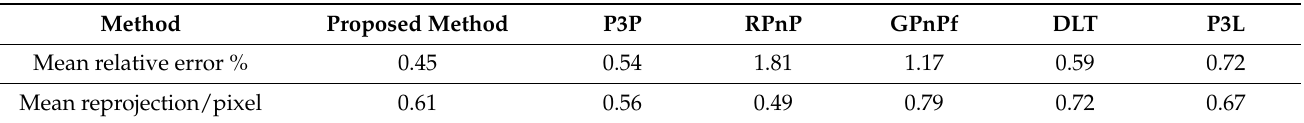
Table 2. Mean relative position errors and mean reprojection